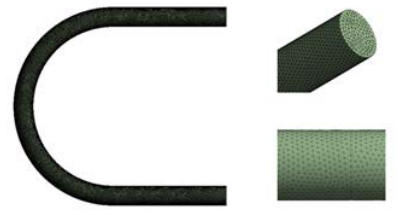
Figure 3. Fluid grid structure.